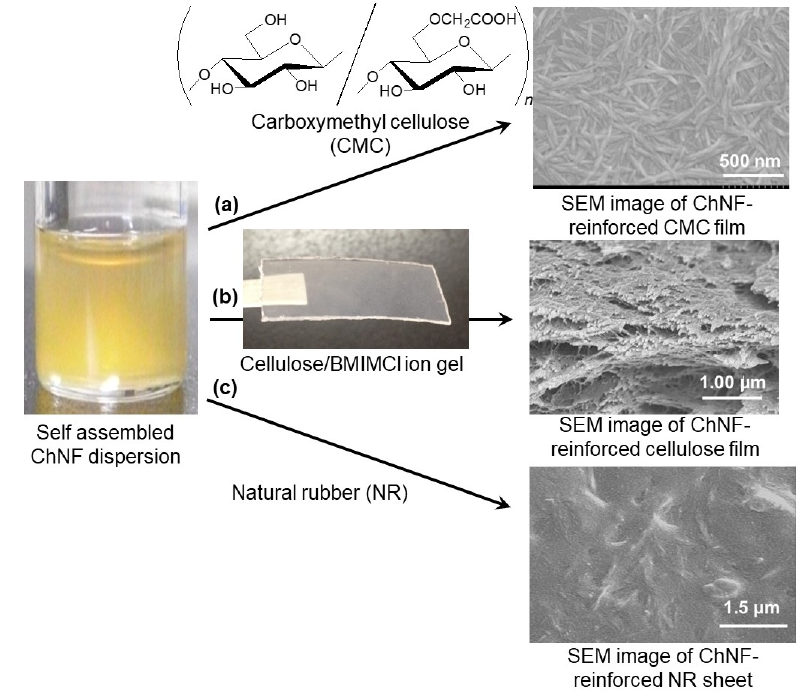
Figure 8. Preparations of ChNF-reinforced: ( a ) CMC film; ( b ) cellulose film; and ( c ) NR